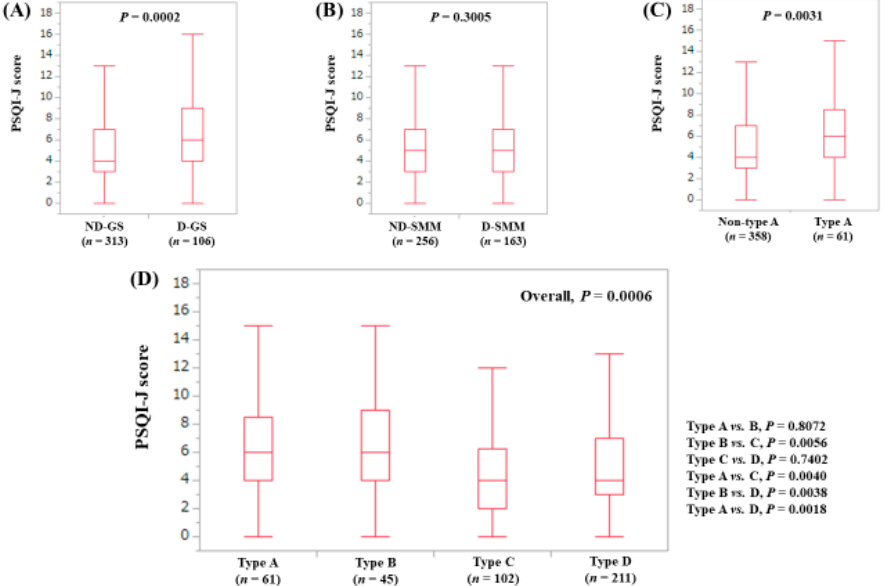
Figure 2. PSQI ‐ J score stratified by GS and SMM for all cases ( n = 419). ( A ) Non ‐ decreased GS